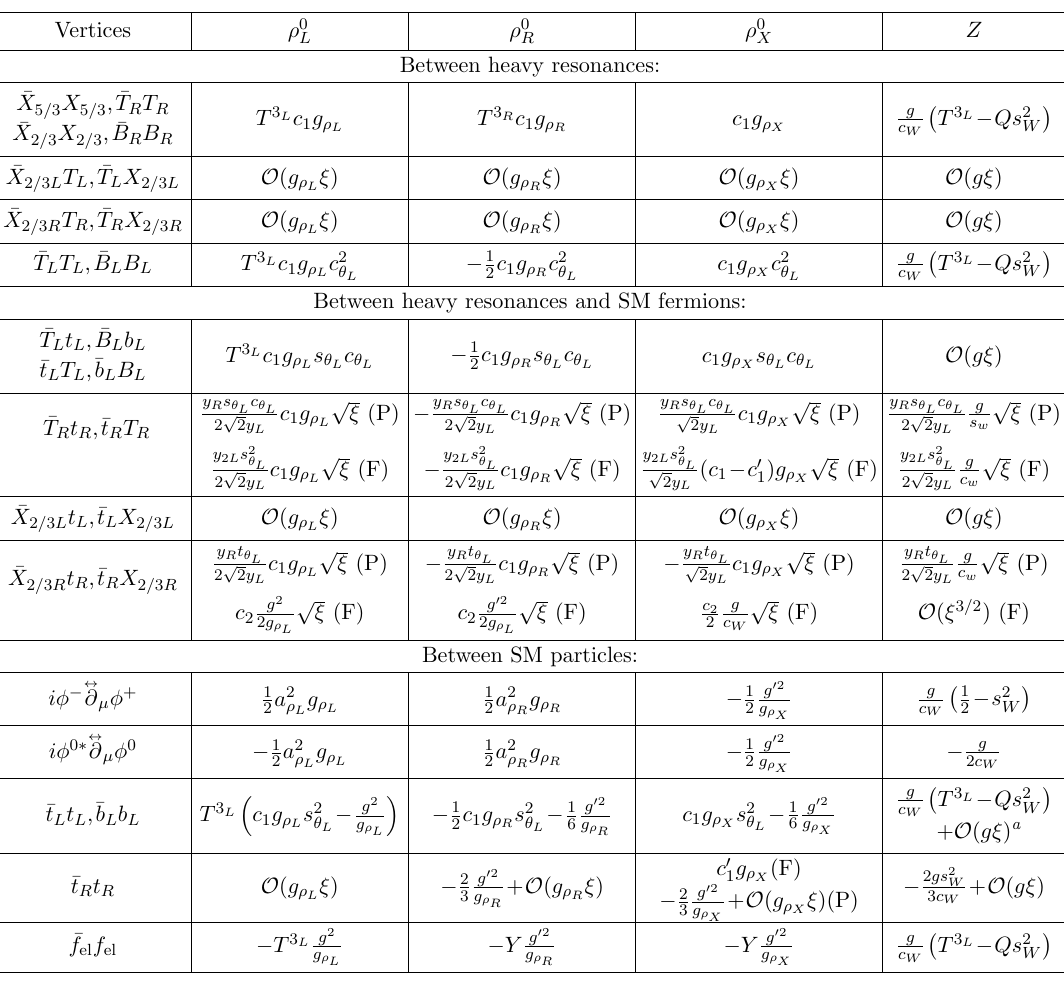
and Z , and the L;R;X